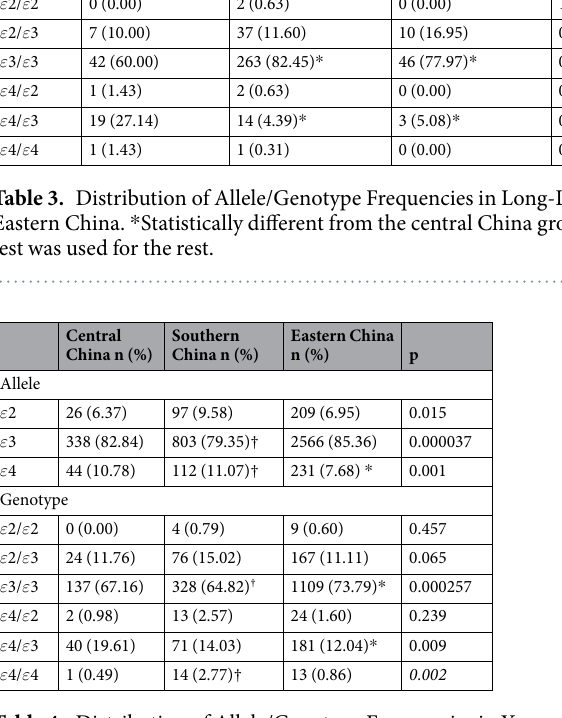
Table 4. Distribution of Allele/Genotype Frequencies in Younger Controls from Central, Southern and Eastern China. Statistically different from the central China group. † Statistically different from the eastern China